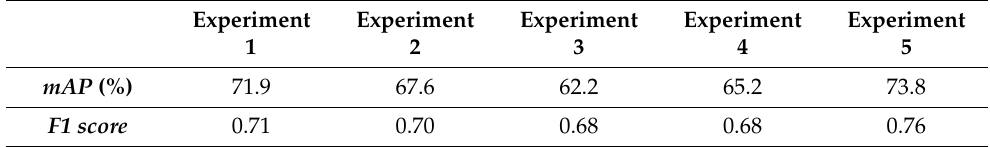
Table 16. Results of YOLOv5-DH on CCTSDB2021 dataset.